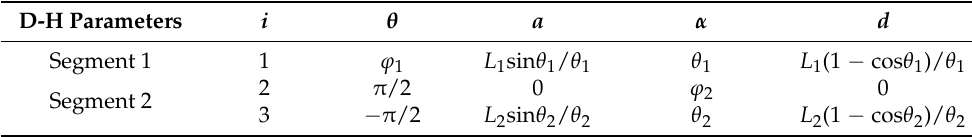
Table 2. NCR’s D-H parameters.